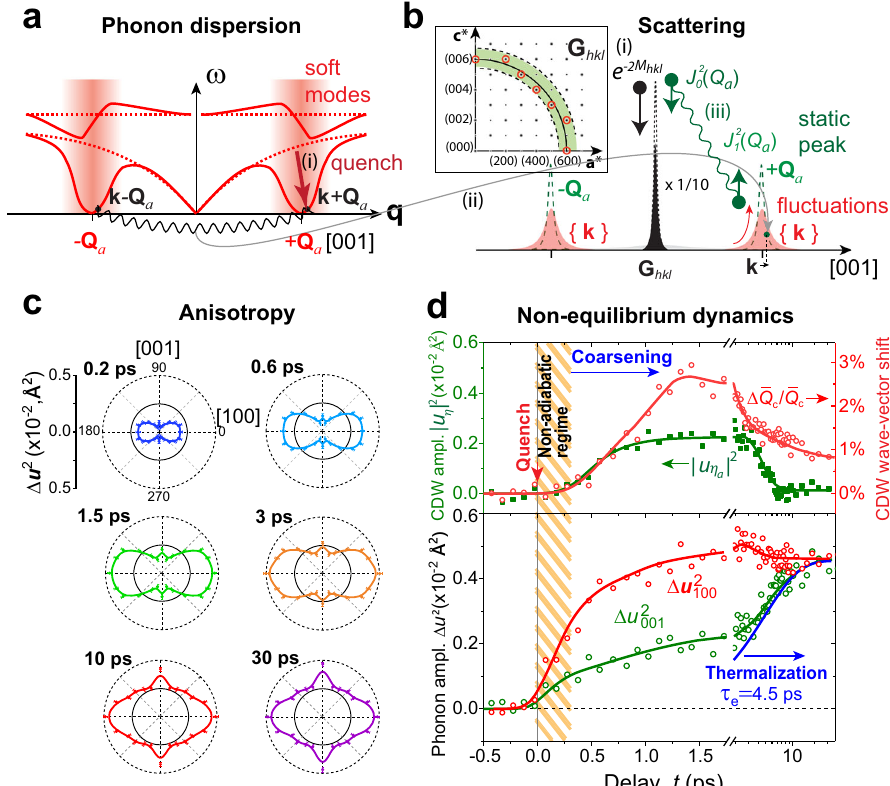
Fig. 5 Symmetry-breaking and recovery energy landscapes and soft modes dynamics. a The anticipated change in the phonon dispersion curves associated with a symmetry-breaking phase transition to form the a -CDW state. The phonon modes near the wavevector ( Q a ) of the emerging a -CDW is softened (shaded area) upon laser quench. b Scattering weight transfer between a lattice Bragg peak ( S G ) and CDW satellite ( S Q ) in different stages of symmetry-breaking phase transformation. (1) the excitation of phonons upon laser quench; (2) the transfer of scattering weight from the lattice peak ( S G ) to the CDW ( S Q ) peak due to pairing of phonons; (3) the nonequilibrium phase ordering. c The mean-squared ( ms ) phonon amplitude changes obtained (cid:1) using Bragg peaks at | G hkl | ~6 r.l.u. (see b ) shown in polar coordinates, indicating strong anisotropy. d (Top) The order parameter fi eld evolution examined (cid:1) via u 0 ; η a